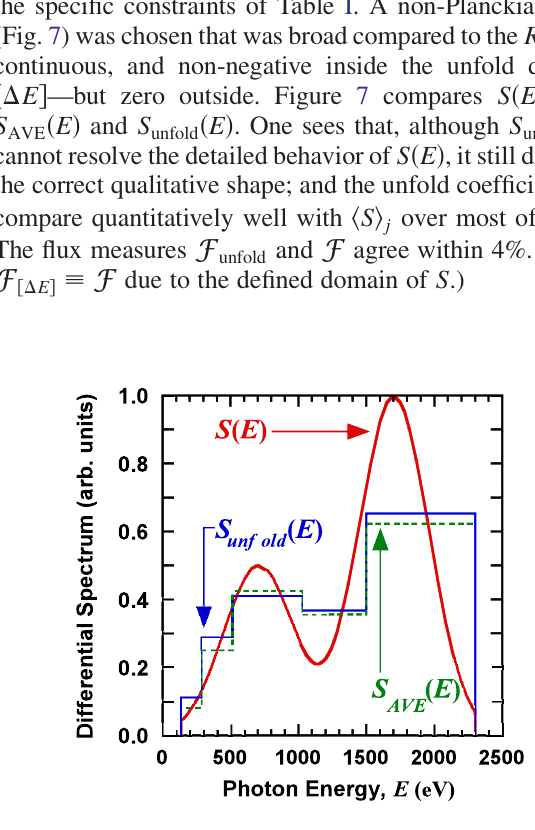
FIG. 7. Comparison of a non-Planckian, test spectrum S ð E Þ ð E Þ and S ð E Þ . Here, S ð E Þ satisfies Table I, and with S AVE unfold ð E Þ is constructed from h S i ð E Þ is the best least- S . [ S j AVE AVE squares approximation to S ð E Þ by the given basis functions ð E Þ ; its rms measure [121] of closeness is 0.43 on a 0–1 scale, B j ð E Þ is the unfold for where 0 signifies exact agreement.] S unfold g (Fig. 1); its relative ; . . . ; R data simulations with S ð E Þ and f R 1 5 (cid:5) 1 Þ , ranges from a few percent near the = h S i distortion, ð S j j spectral peak to (cid:3) 36% in the lowest x-ray energy bin, which contains relatively little